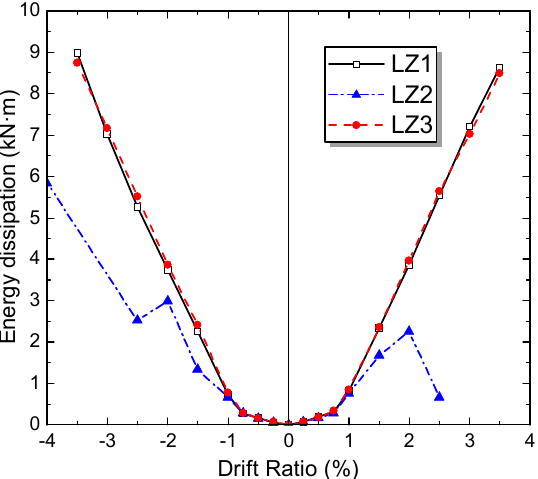
Figure 9. Energy dissipation evolutions.